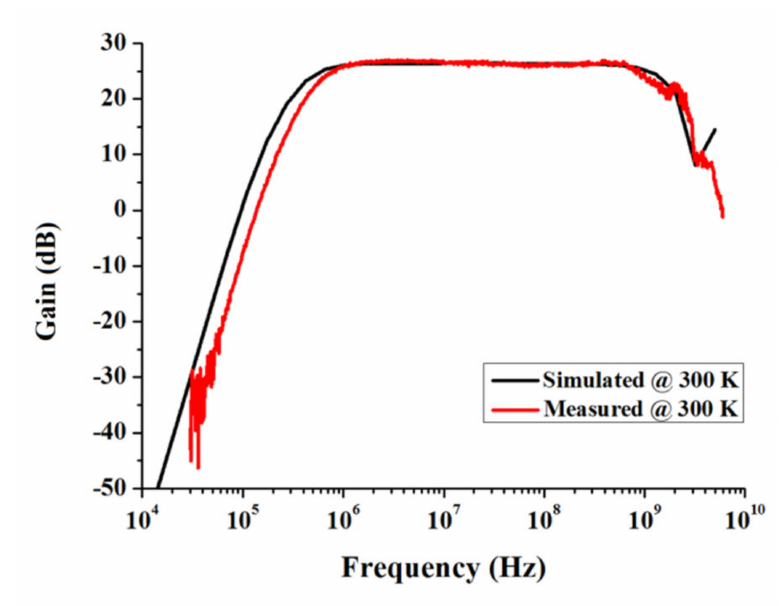
Figure 12. Simulated and measured gain of the amplifier at 300